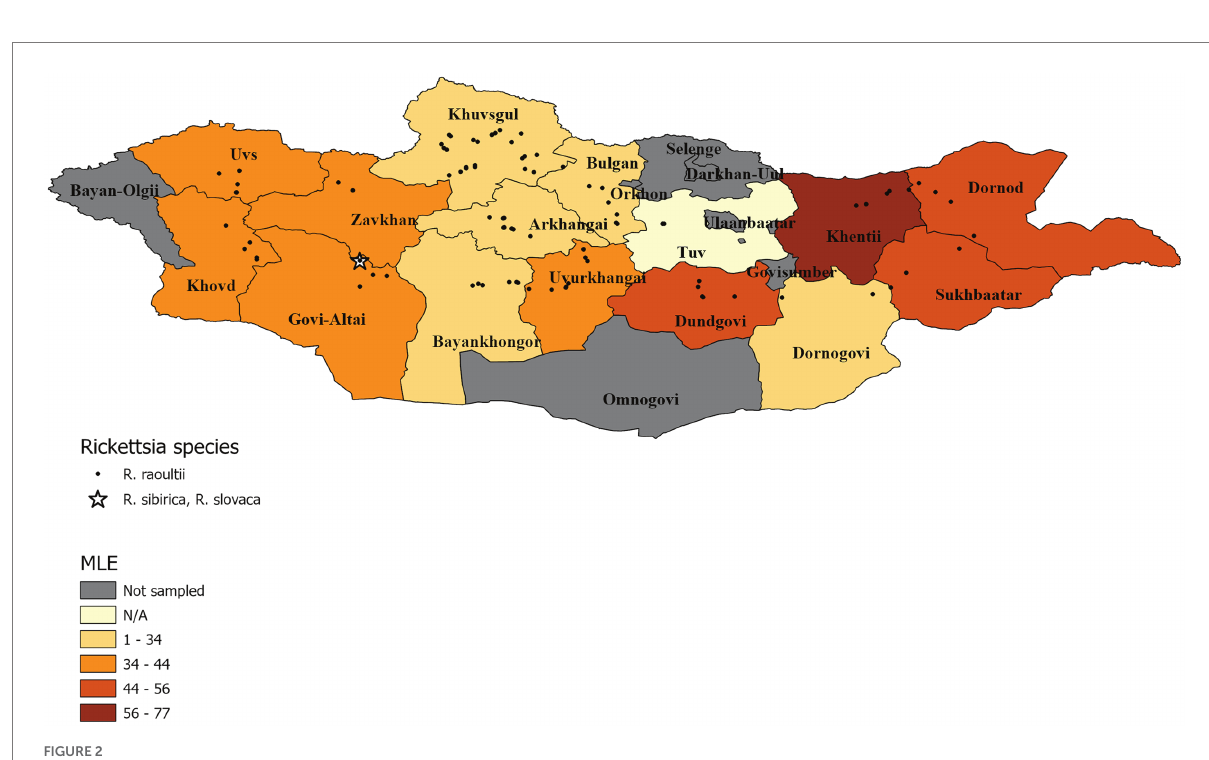
found in tick pools collected from eastern and western aimags of Mongolia, with lower MLEs seen in central aimags (Figure 2).